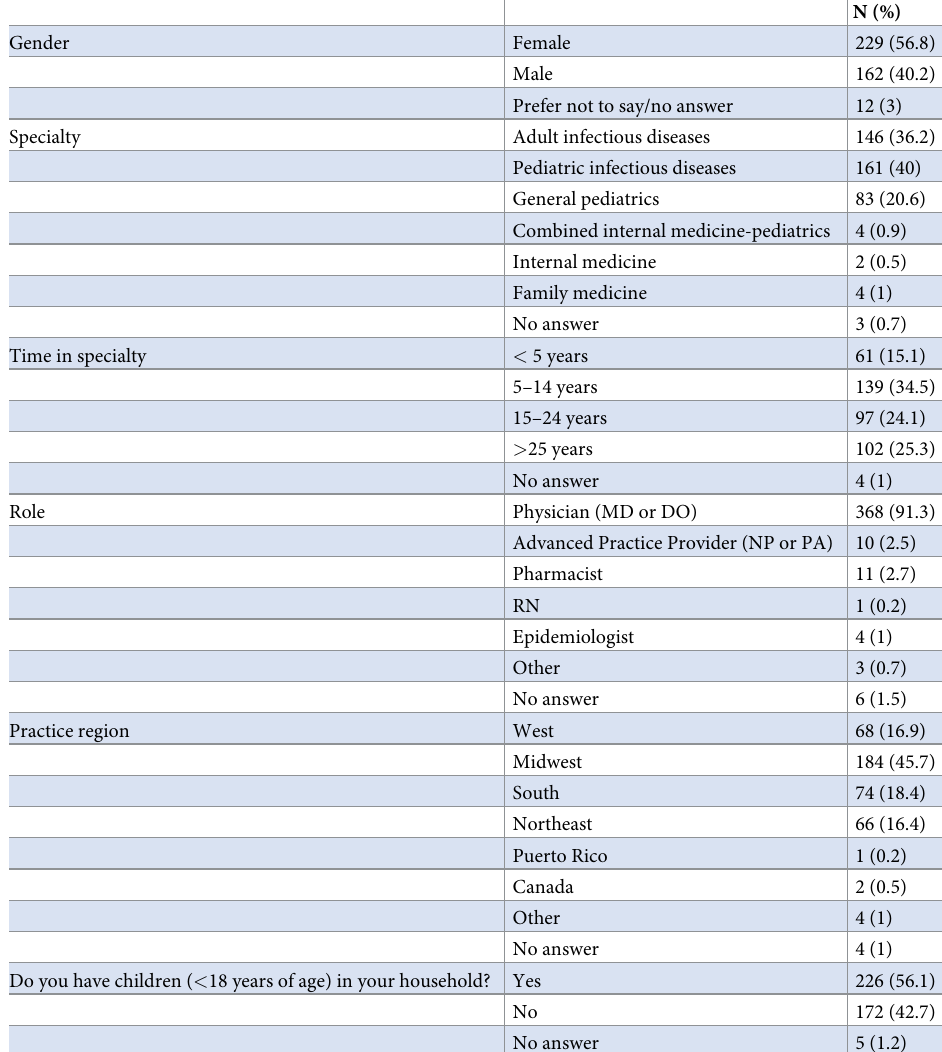
Table 1. Demographic data of 403